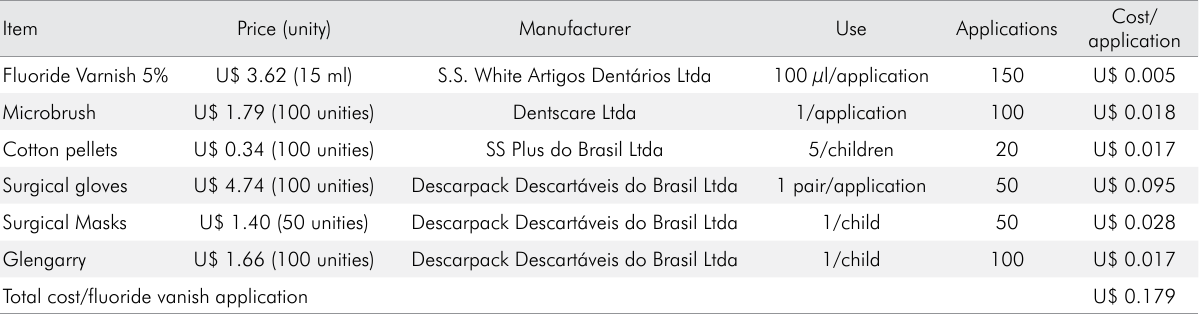
Table 1. Cost calculation for the application of Fluoride Varnish.